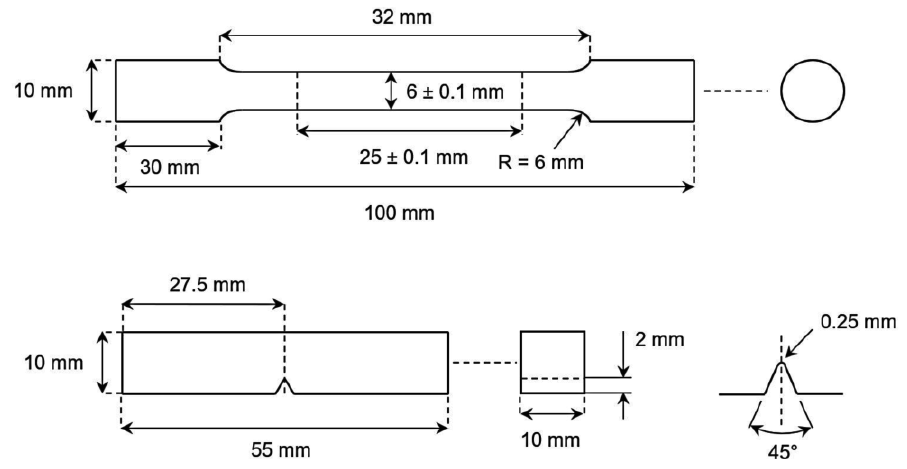
Figure 3. Scheme showing tensile and impact samples used in this work.